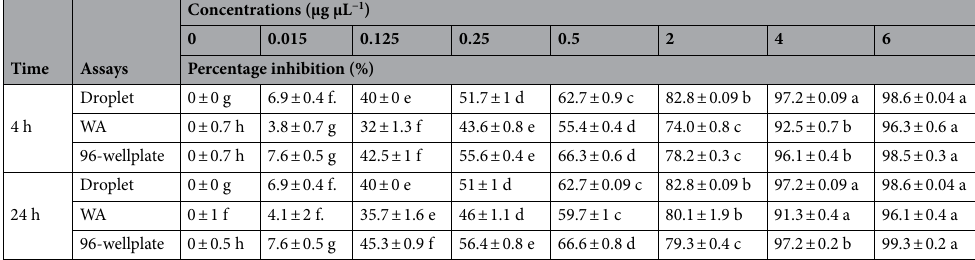
Table 2. Comparison of in vitro inhibition potential of kunshi against spore germination of A. alternata assessed via three assays i.e., WA, 96-well plate, and droplet assay. Each concentration with different letters is significantly different from each other ( P < 0.05; Statistix 8.1). The significance was calculated by Tukey’s HSD post-hoc test ( P = 0.05). ± Represents standard error of means (n = 6 in case of WA and 96-well plate, n = 140 in case of droplet assay).